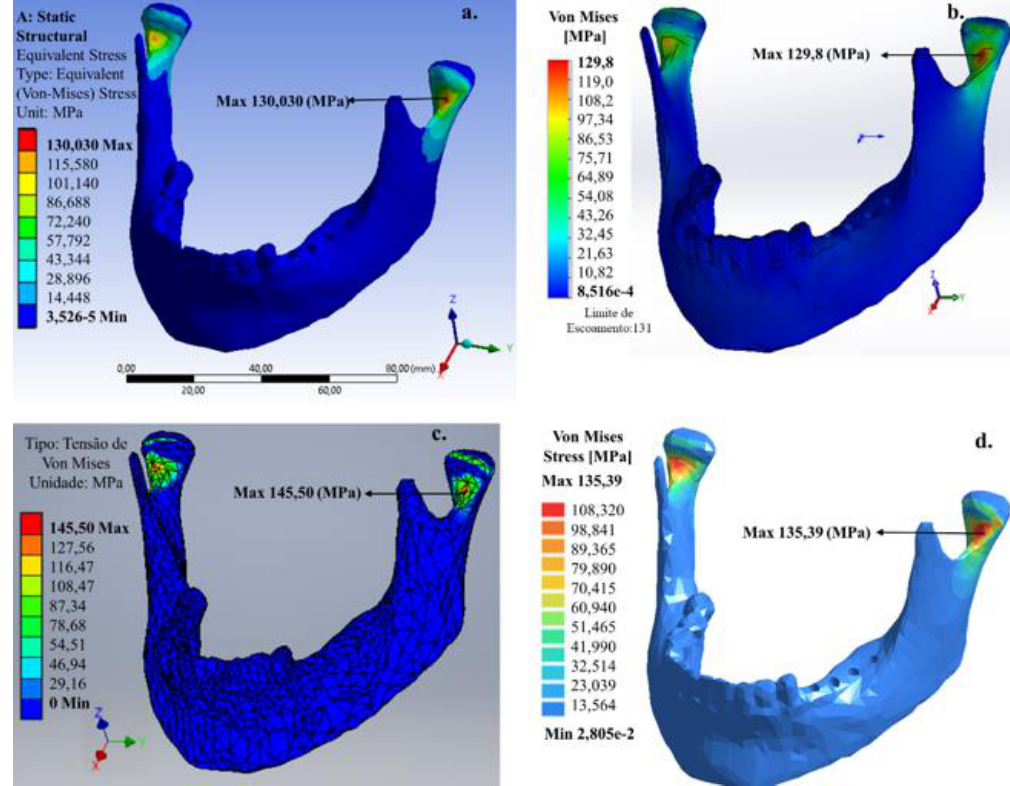
Figure 5. Von Mises stress distribution in the mandible applying 200 N load on the right lateral area of the lower dental arch: ( a ) Ansys ® , ( b ) SolidWorks ® , ( c ) Inventor ® and ( d ) SimSolid ® software.